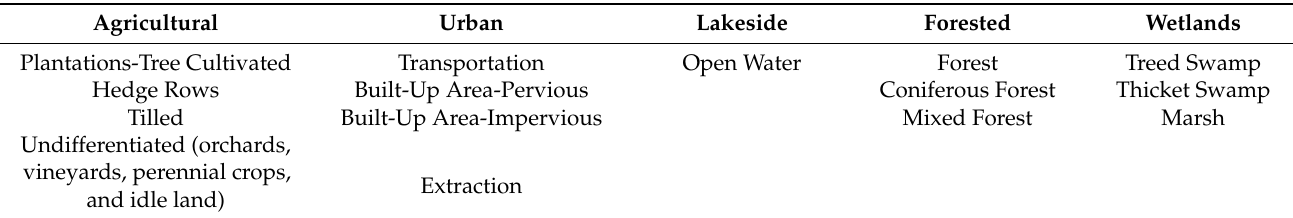
Table 1. The reclassification of all land covers into five manageable categories. Any station located in proximity to an open water land cover is reclassified as a lakeside station regardless of the dominant land cover within 100